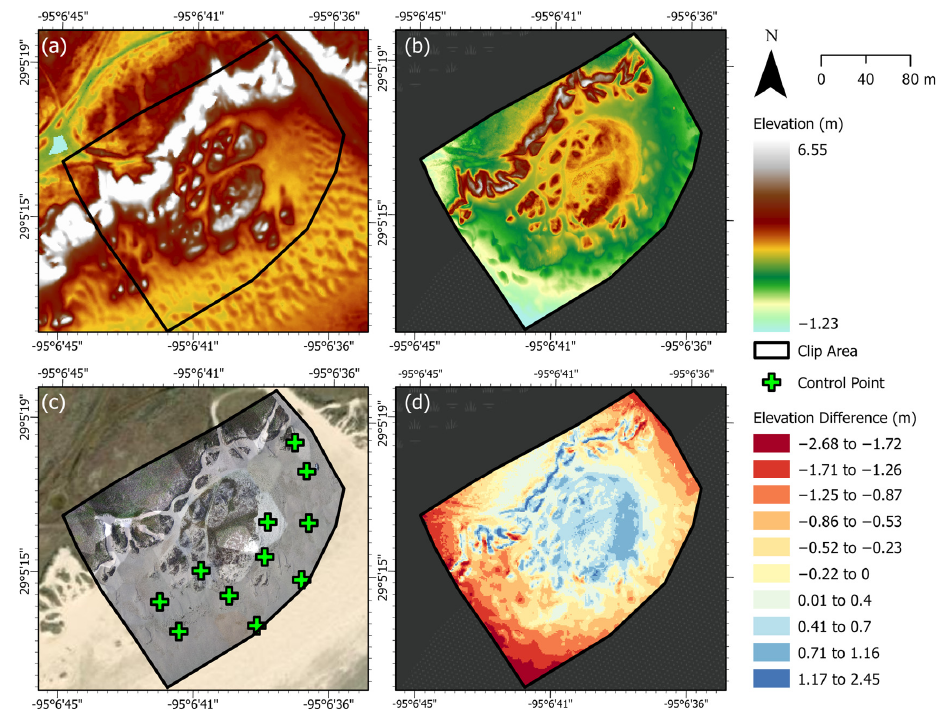
Figure 18. Galveston Site comparison of 2022 UAV data and 2018/2019 data. Spatial Reference: NAD 1983 UTM Zone 15n. ( a ) 2018/2019 NOAA’s Post Hurricane Harvey elevation model with survey clipping boundary; ( b ) May 2022 digital elevation model; ( c ) May 2022 orthophoto with a World Imagery Maxar base map; ( d ) The elevation difference map with erosion represented as light green through red, and deposition represented by shades of blue.